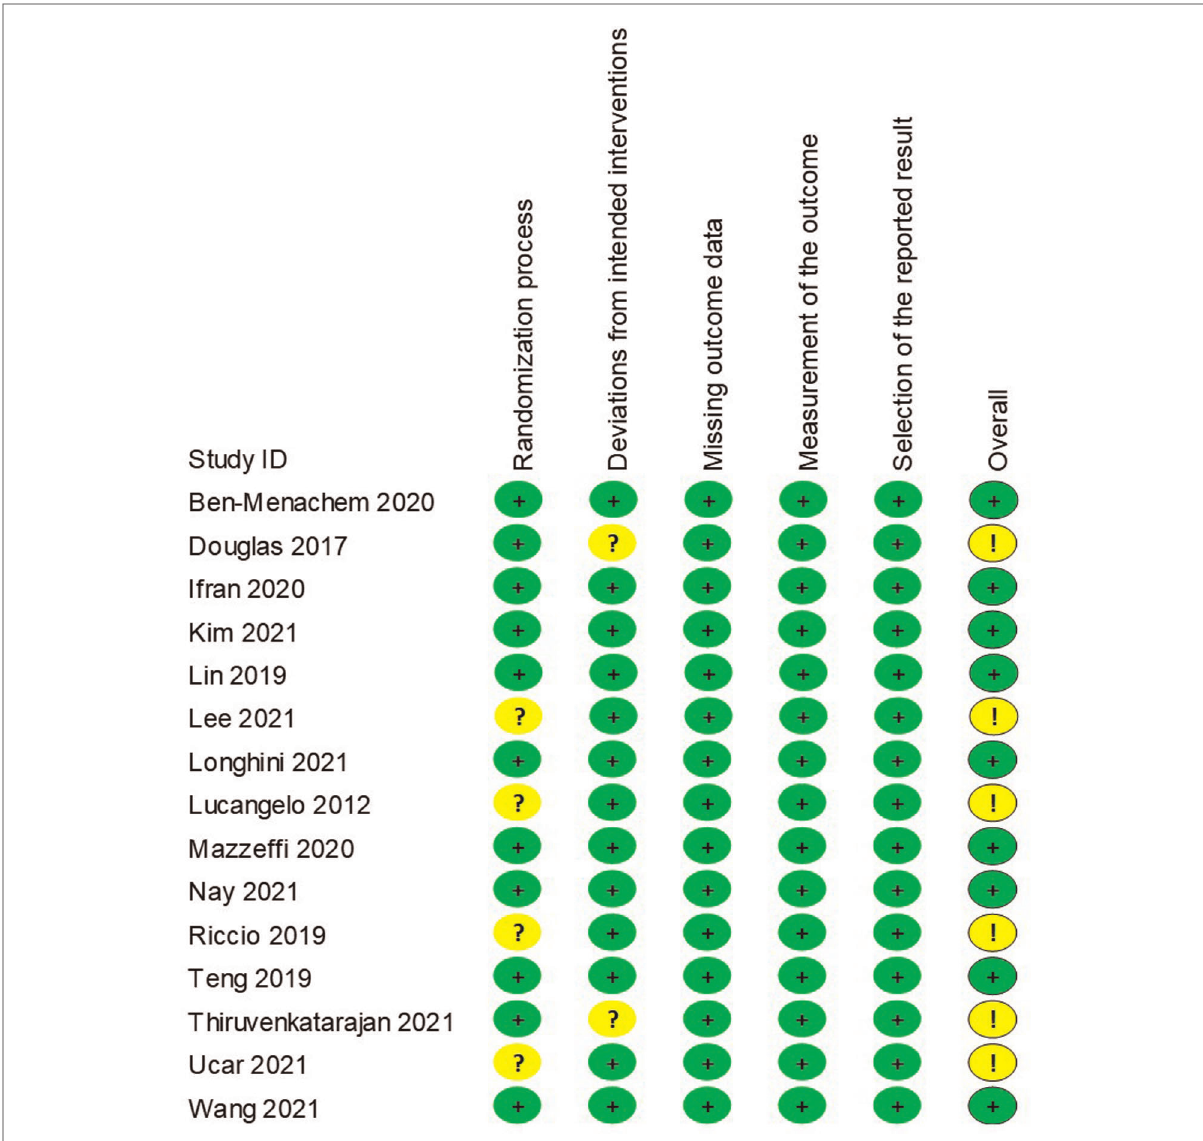
FIGURE 9 Revised risk of bias of randomised controlled trials. Green circle, low risk; yellow circle, some concerns; red circle, high